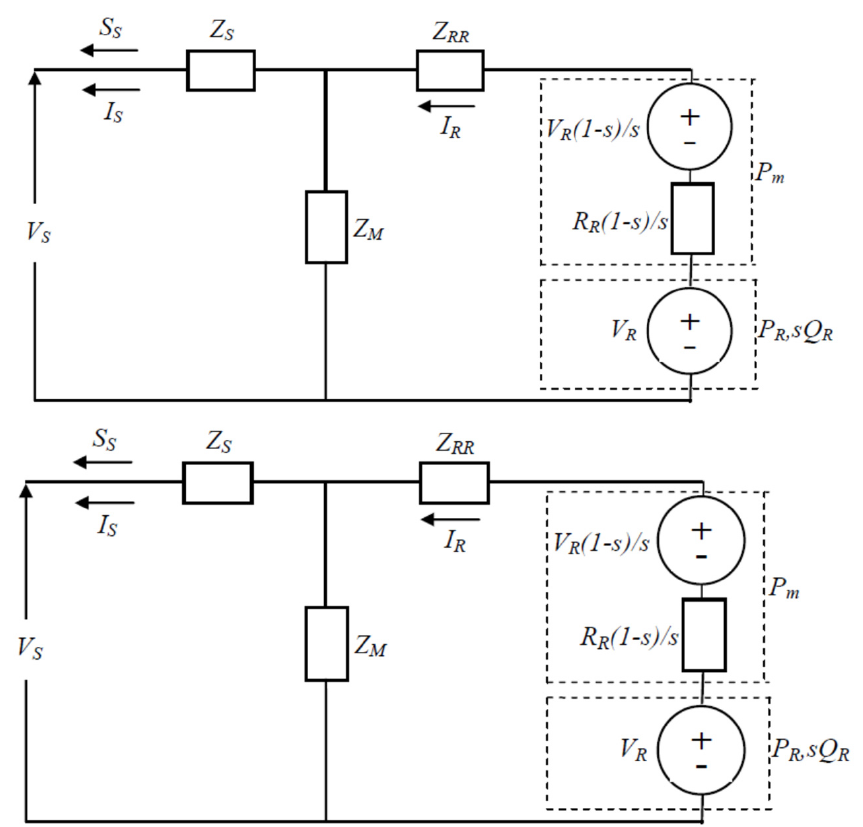
Figure 5. Modified equivalent circuits of WRIG (in terms of impedances).